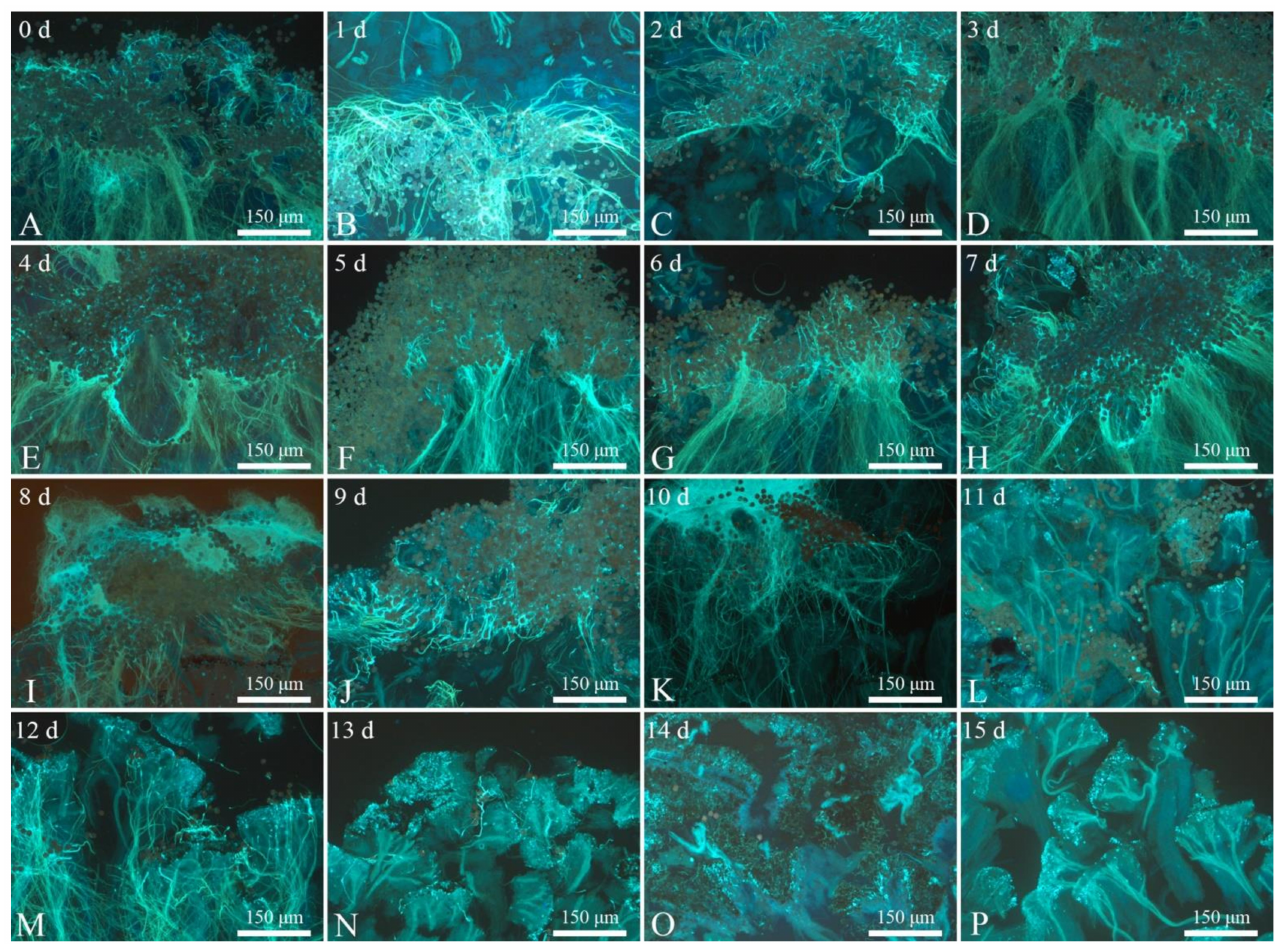
Figure 8. Observation of pollen tube growth on the stigma after artificial pollination under a fluorescence microscope. ( A